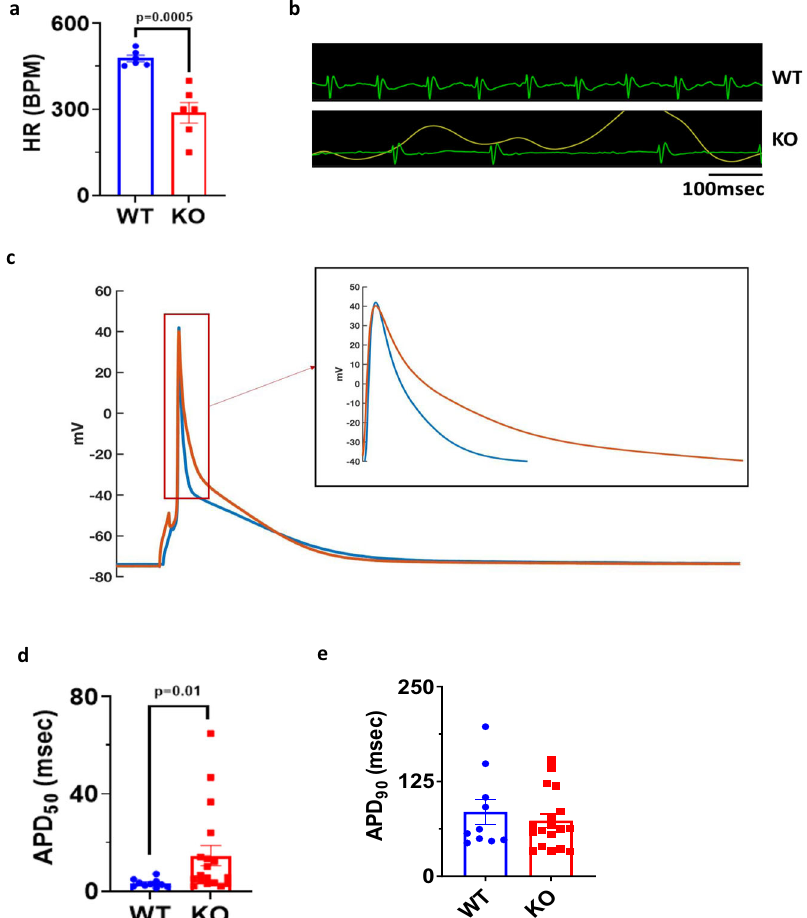
Fig. 5 Altered action potential in VDAC2-KO cardiomyocytes. a Heart rate (HR), beats per minute (BPM) ( p = 0.0005) ( n = 6); b Representative ECG of 16-week-old mice (time frame, 100 ms); c Representative action potential image of 16-week-old mice cardiomyocyte (time frame, 100 ms); d , e Action potential repolarization duration at 50% and 90%, respectively (two-tailed Welch test: APD90 p = ns, APD50 p = 0.0148) (WT n = 10, KO n = 18, N = 3). p -value: unpaired two-tailed t -test and two-tailed Welch test performed. Data are represented as mean ±